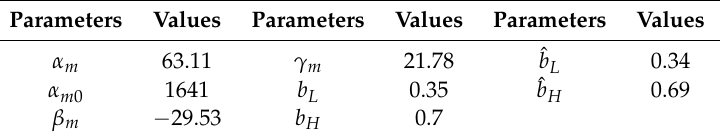
Table A2. Parameter values for the F–SOC function that represent average data. This model is also used for PWL F–SOC without model mismatch ( b L and b H ) and with model mismatch (ˆ b L and ˆ b H ).